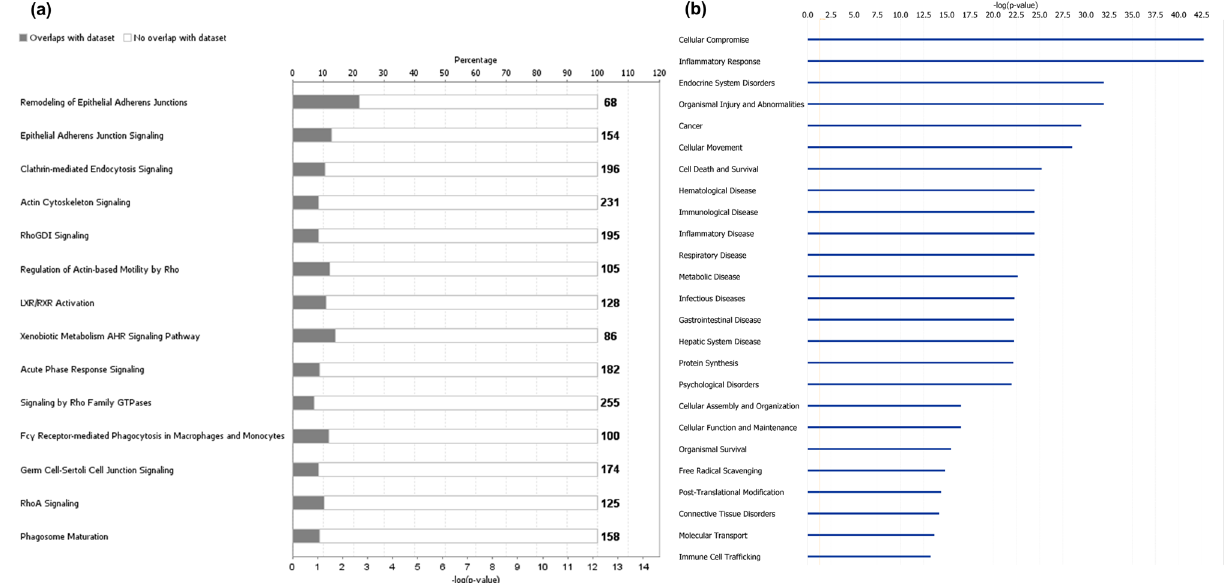
Figure 5. Functional analysis of the equine tracheal wash proteome. Ingenuity Pathway Analysis software was used to determine the (a) most enriched canonical pathways and (b) diseases and biofunctions associated with the protein list (IPA Spring 2021 release, https:// www. qiage nbioi nform atics. com/ produ cts/ ingen uity- pathw ay- analy sis) 30